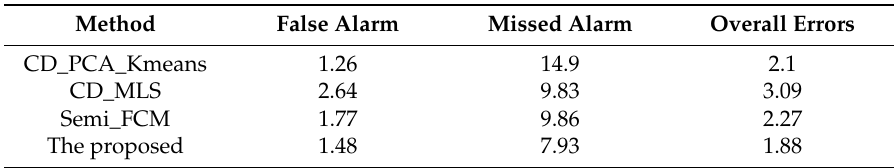
Table 4. Change Detection Quantitative Evaluation (%) on the Sardinia Island dataset (more details can be tracked in Table S4.).